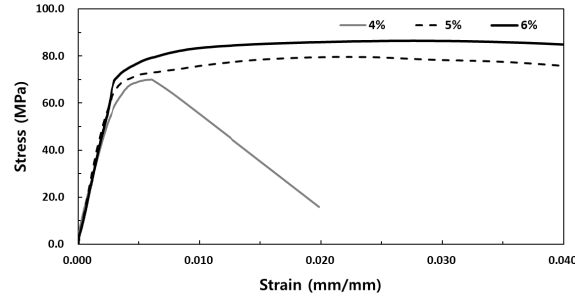
Figure 11. The stress-strain curve with respect to fiber volume fraction.